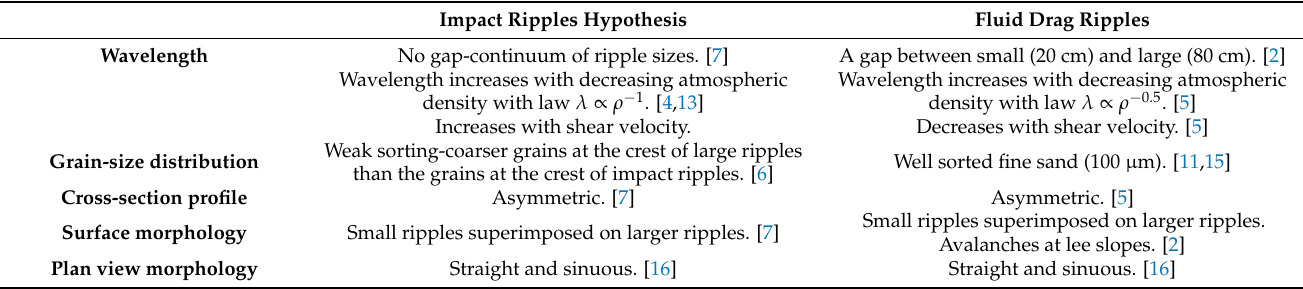
Table 1. Morphological characteristics of large ripples according to impact ripples and fluid drag ripple